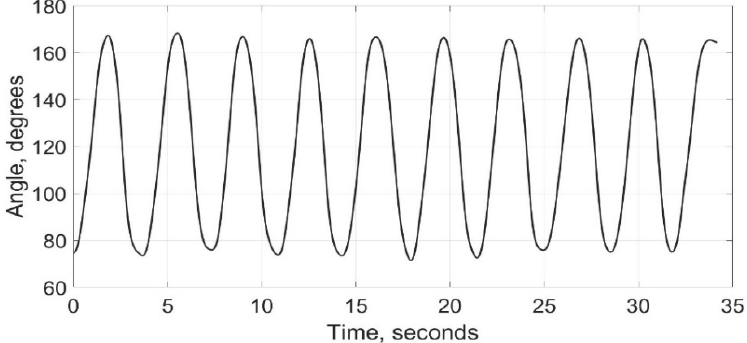
Figure 4. A range of movement signal.